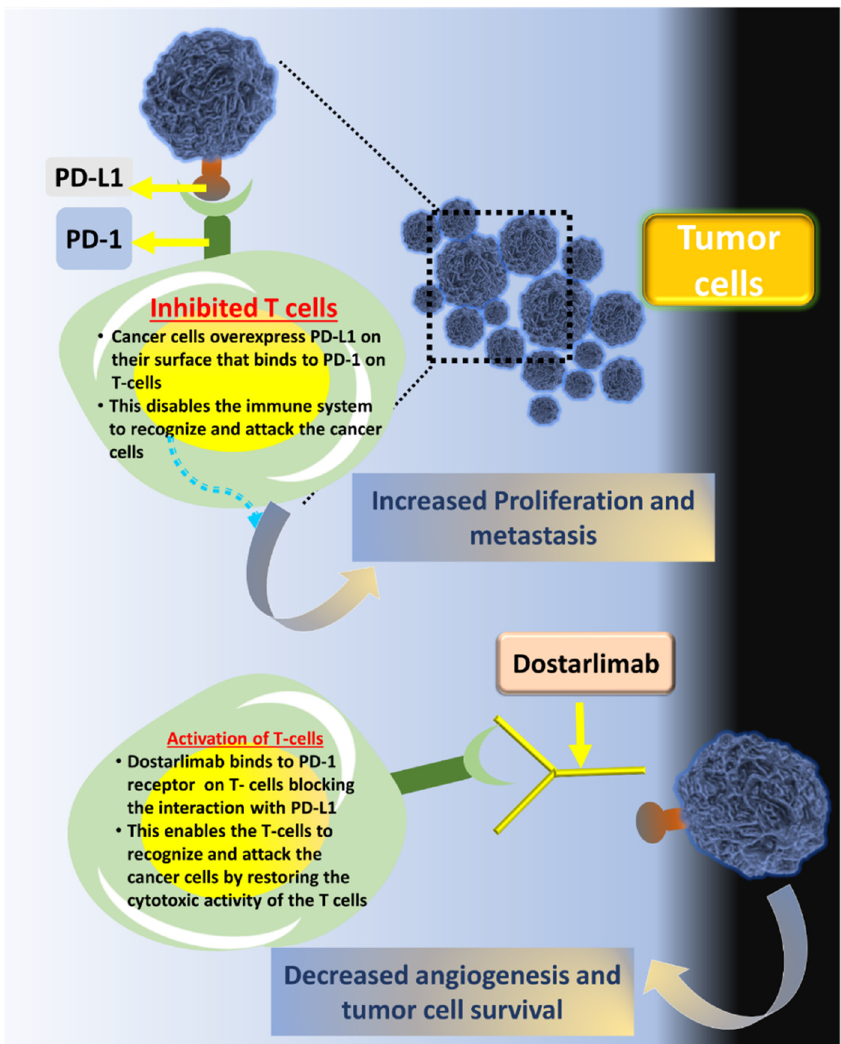
Figure 1. Illustration of the activity of dostarlimab against cancer cells. The PD-1 inhibitor (dostarlimab) inhibits the interaction of T-cells over-expressing PD-1 protein with the ligands (PD-L1) present in cancer cells.